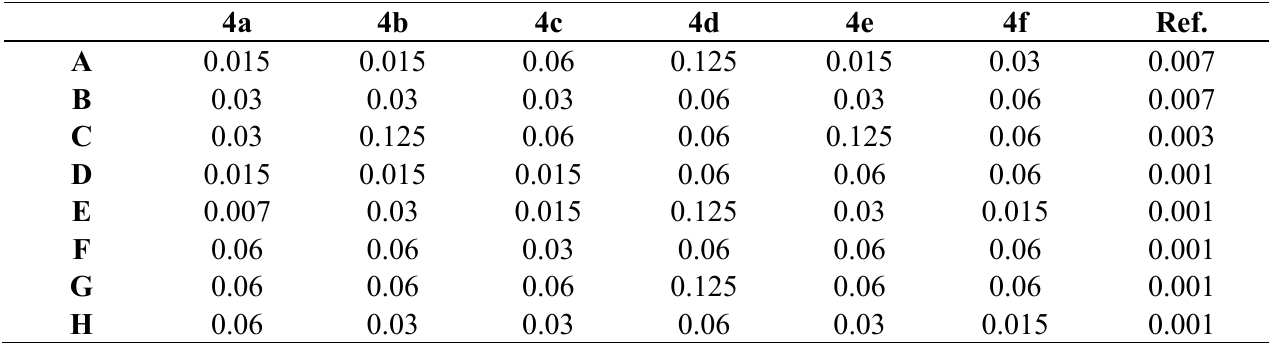
Table 2. Anticandidal activities of novel compounds ( 4a-f ) as MIC values